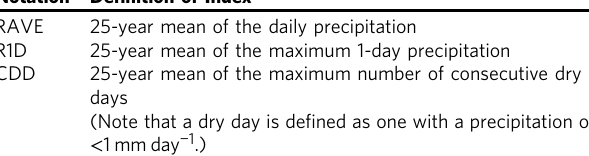
Table 2 The precipitation indices evaluated in this study Notation De fi nition of Index